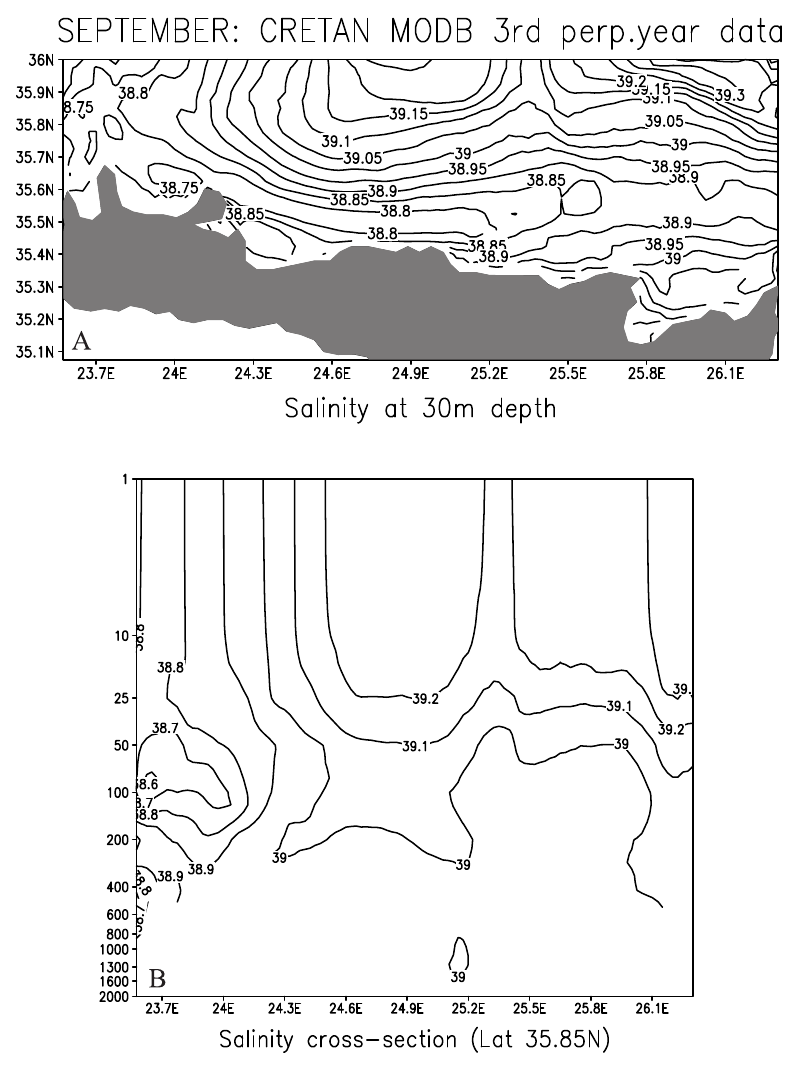
Fig. 6. Salinity profiles of the third per- petual year of SI-MO during late sum- mer, (a) at the sub-surface (30m), and (b) cross section at latitude